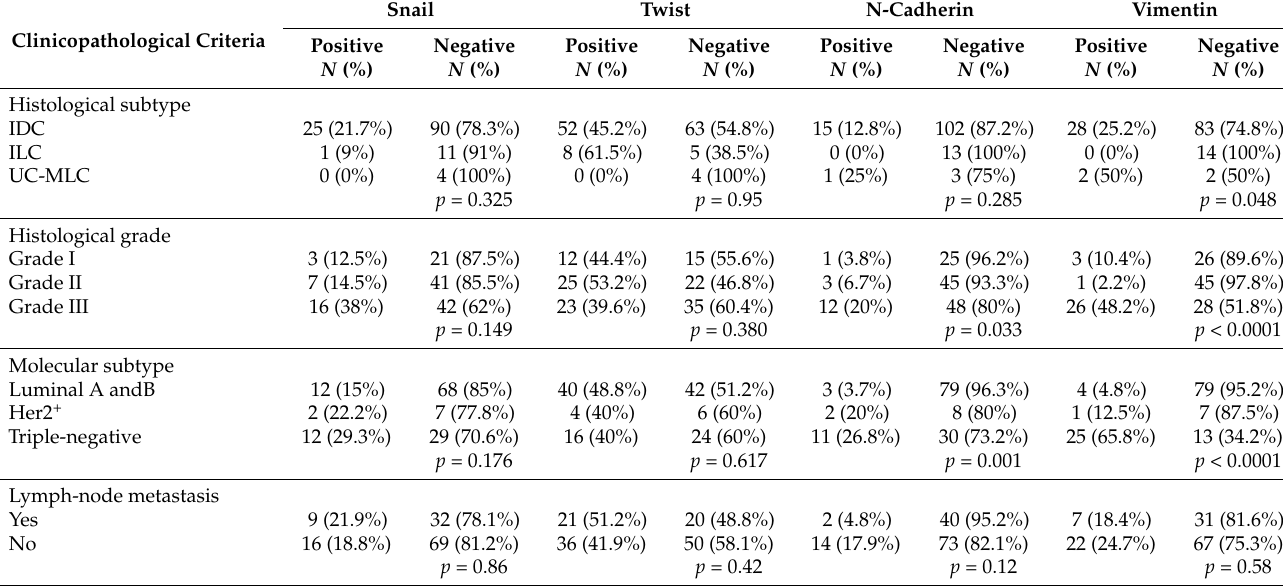
Table 3. Correlation between the level of protein expression of mesenchymal markers and the clinicopathological criteria. Snail Twist N-Cadherin Clinicopathological Criteria